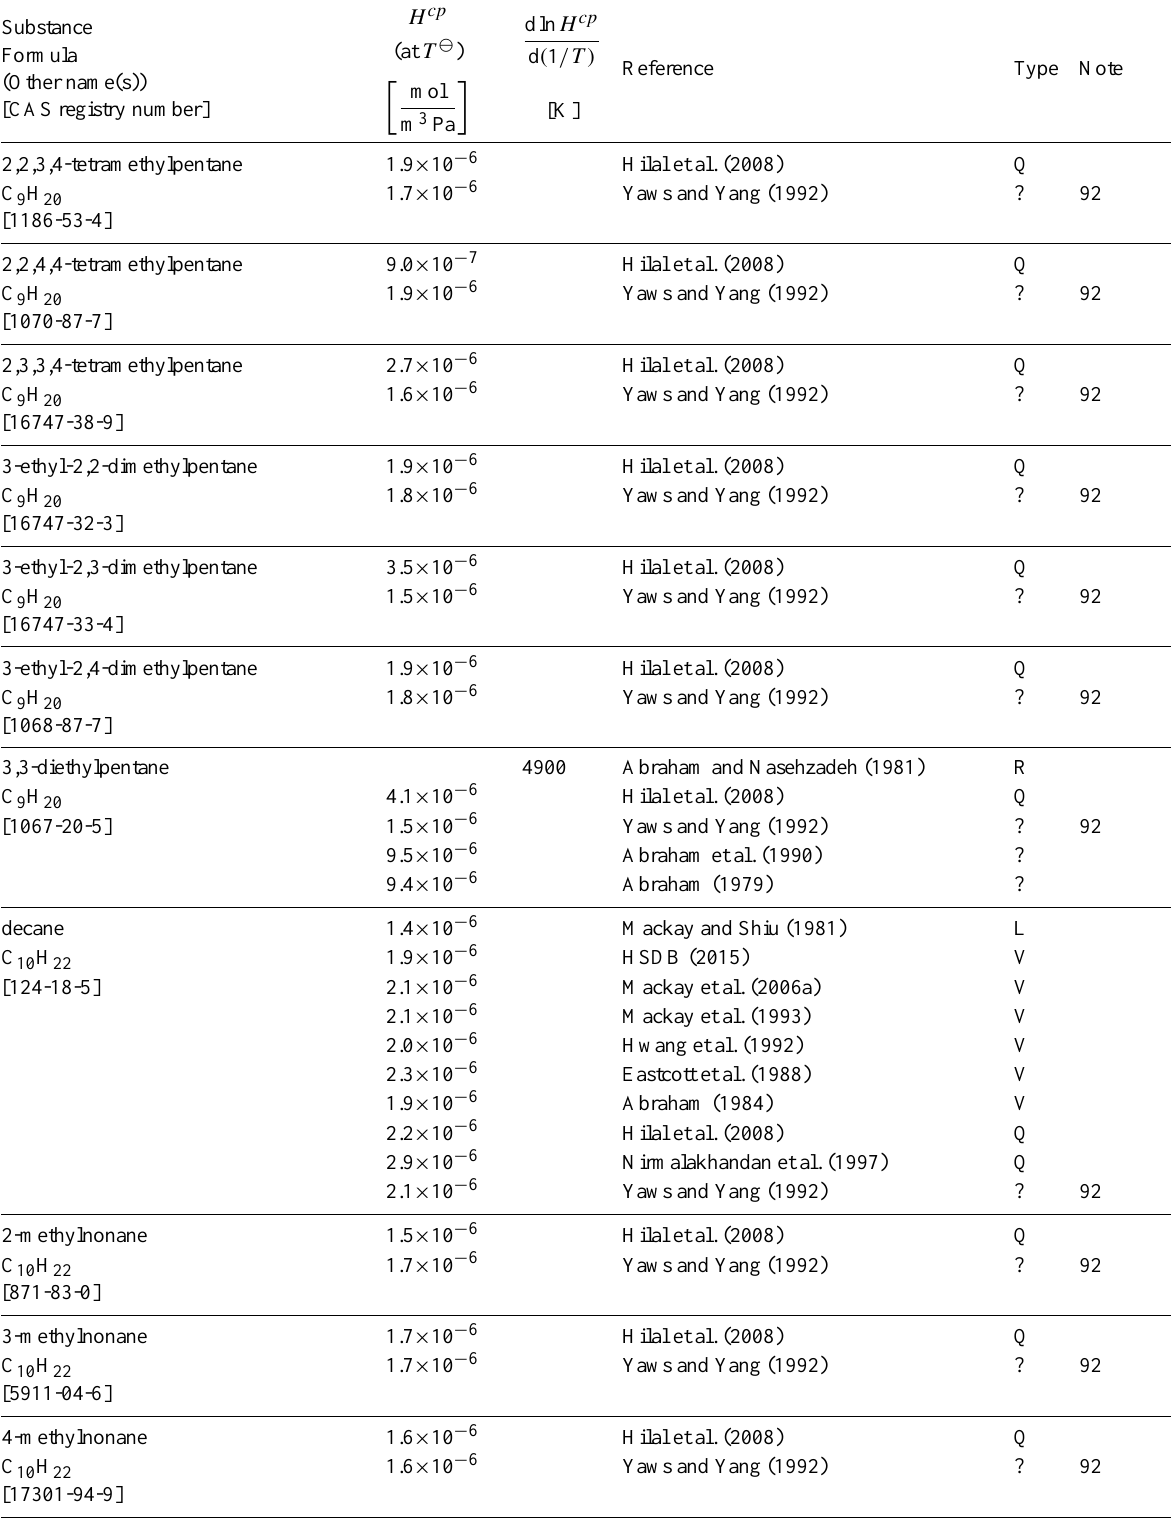
Table 6: Henry’s law constants for water as solvent